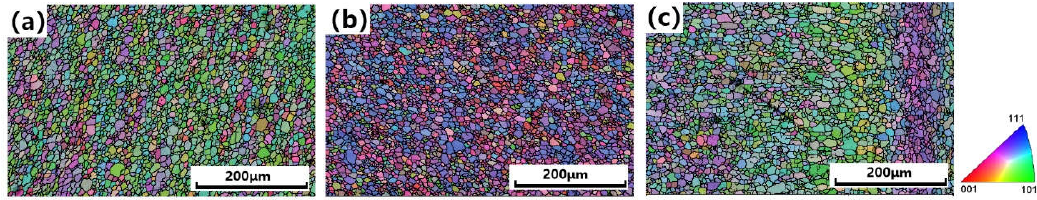
Figure 7. Microstructure evolution in the cross section (ND-TD plane) characterized by EBSD: ( a ) point A2; ( b ) point A4; ( c ) point